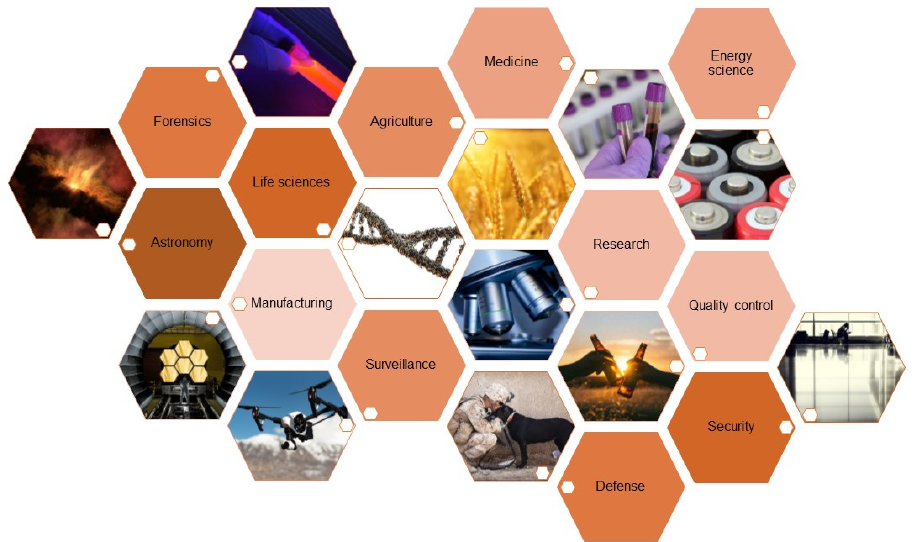
Figure 5. Selected application scenarios where infrared spectroscopy is routinely applied, and which provide growing market shares for infrared spectroscopic tools. Selected images were used from pixabay (pixabay.com; accessed on 18 October 2020).